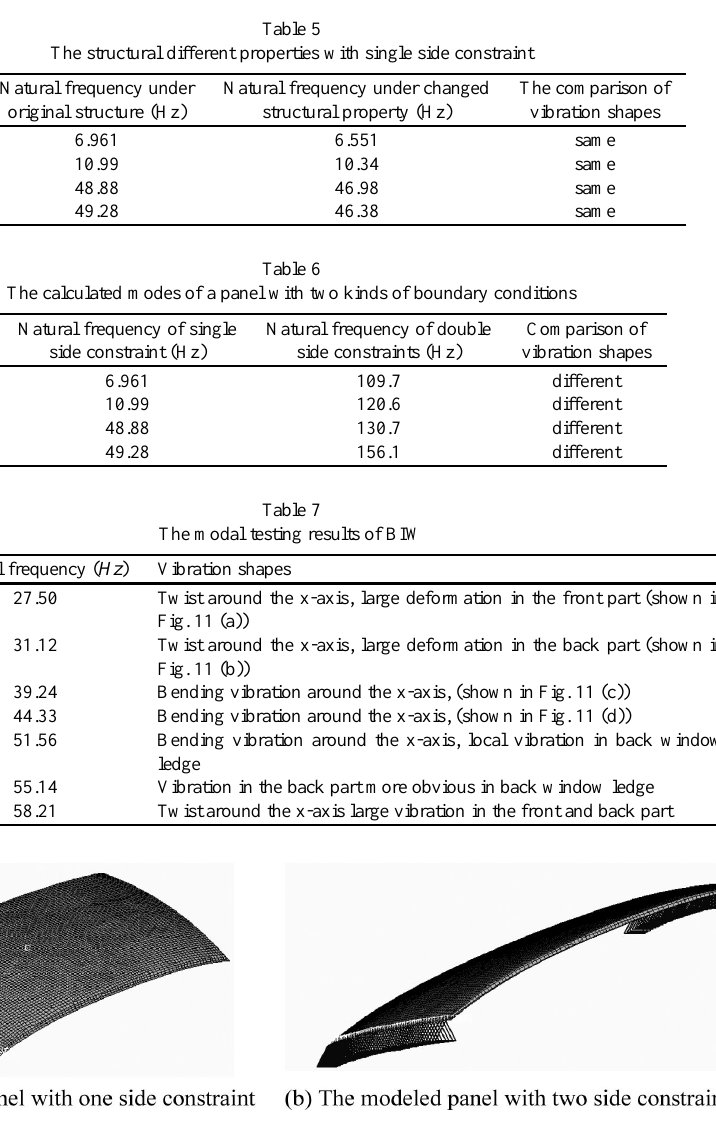
Fig. 8. The two different boundary conditions of a panel with single and double side